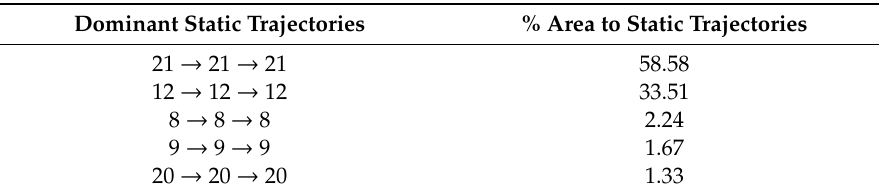
Table 2. The major static trajectories.